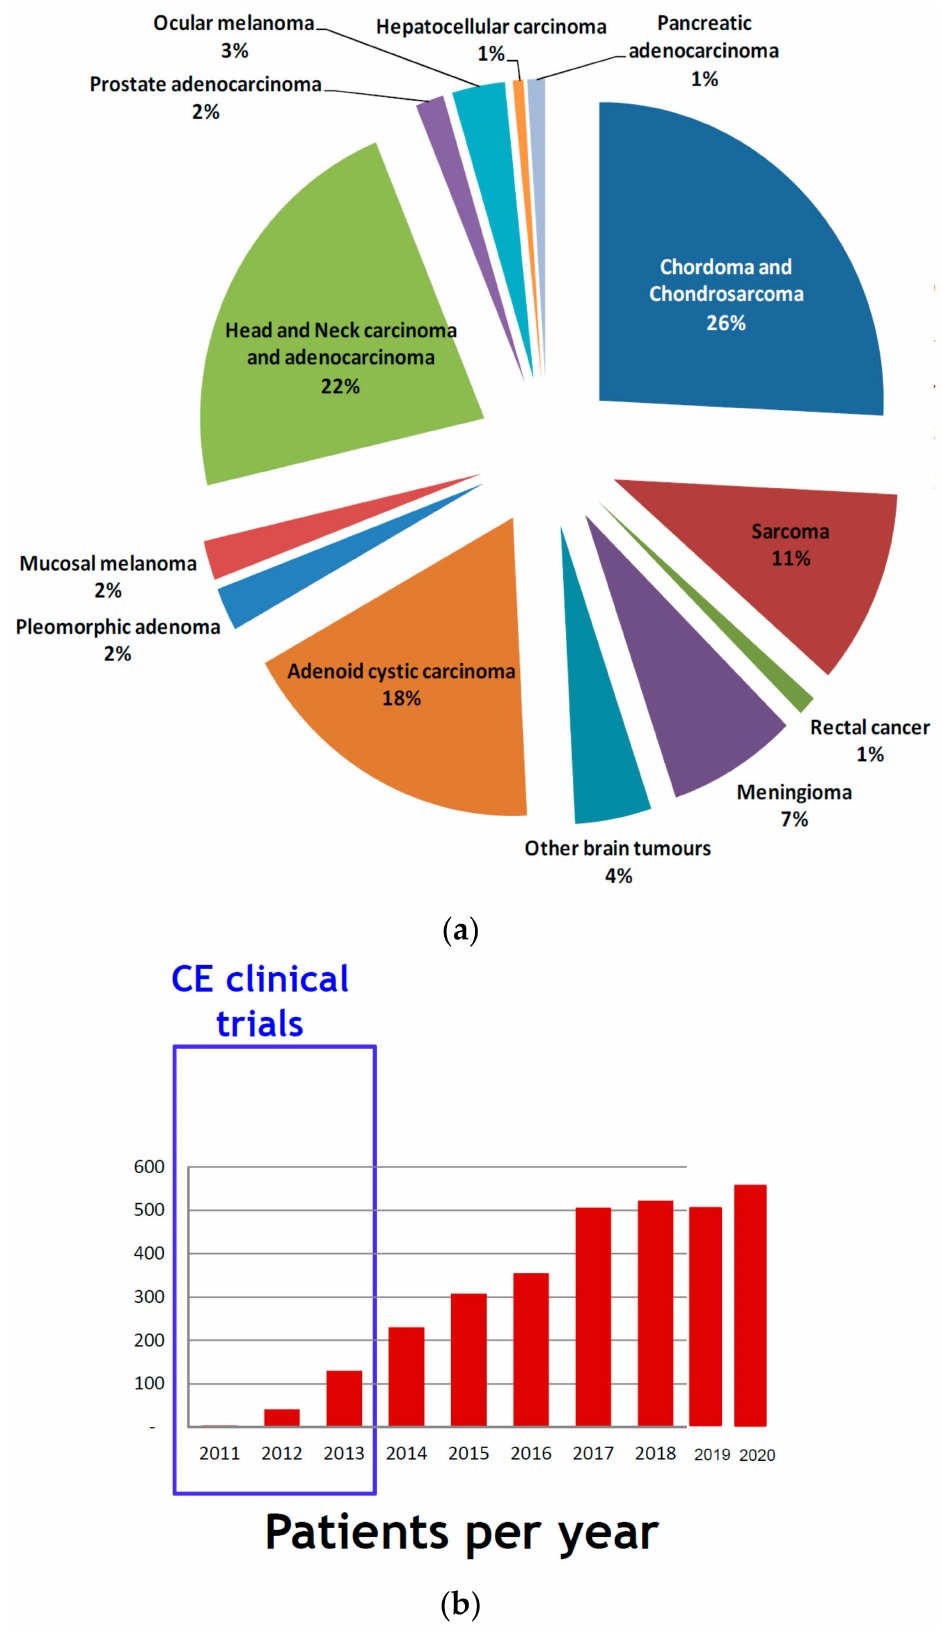
Figure 10. ( a ) Incidence of tumour pathologies treated at CNAO; ( b ) Number of patients treated each year at